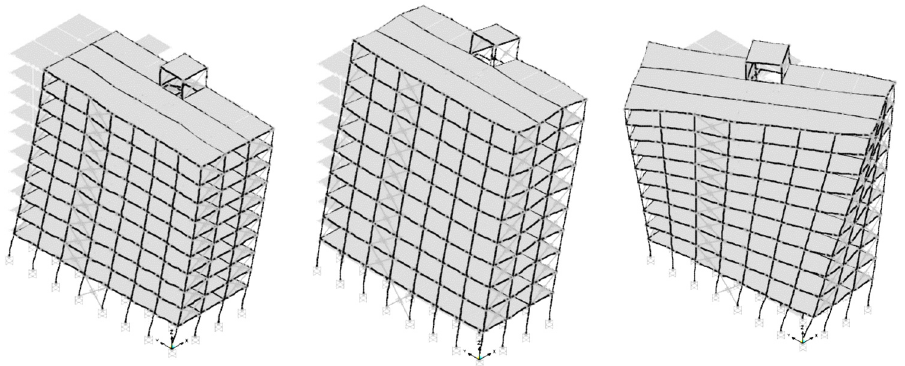
Figure 8. Modal shapes of the FEM model.